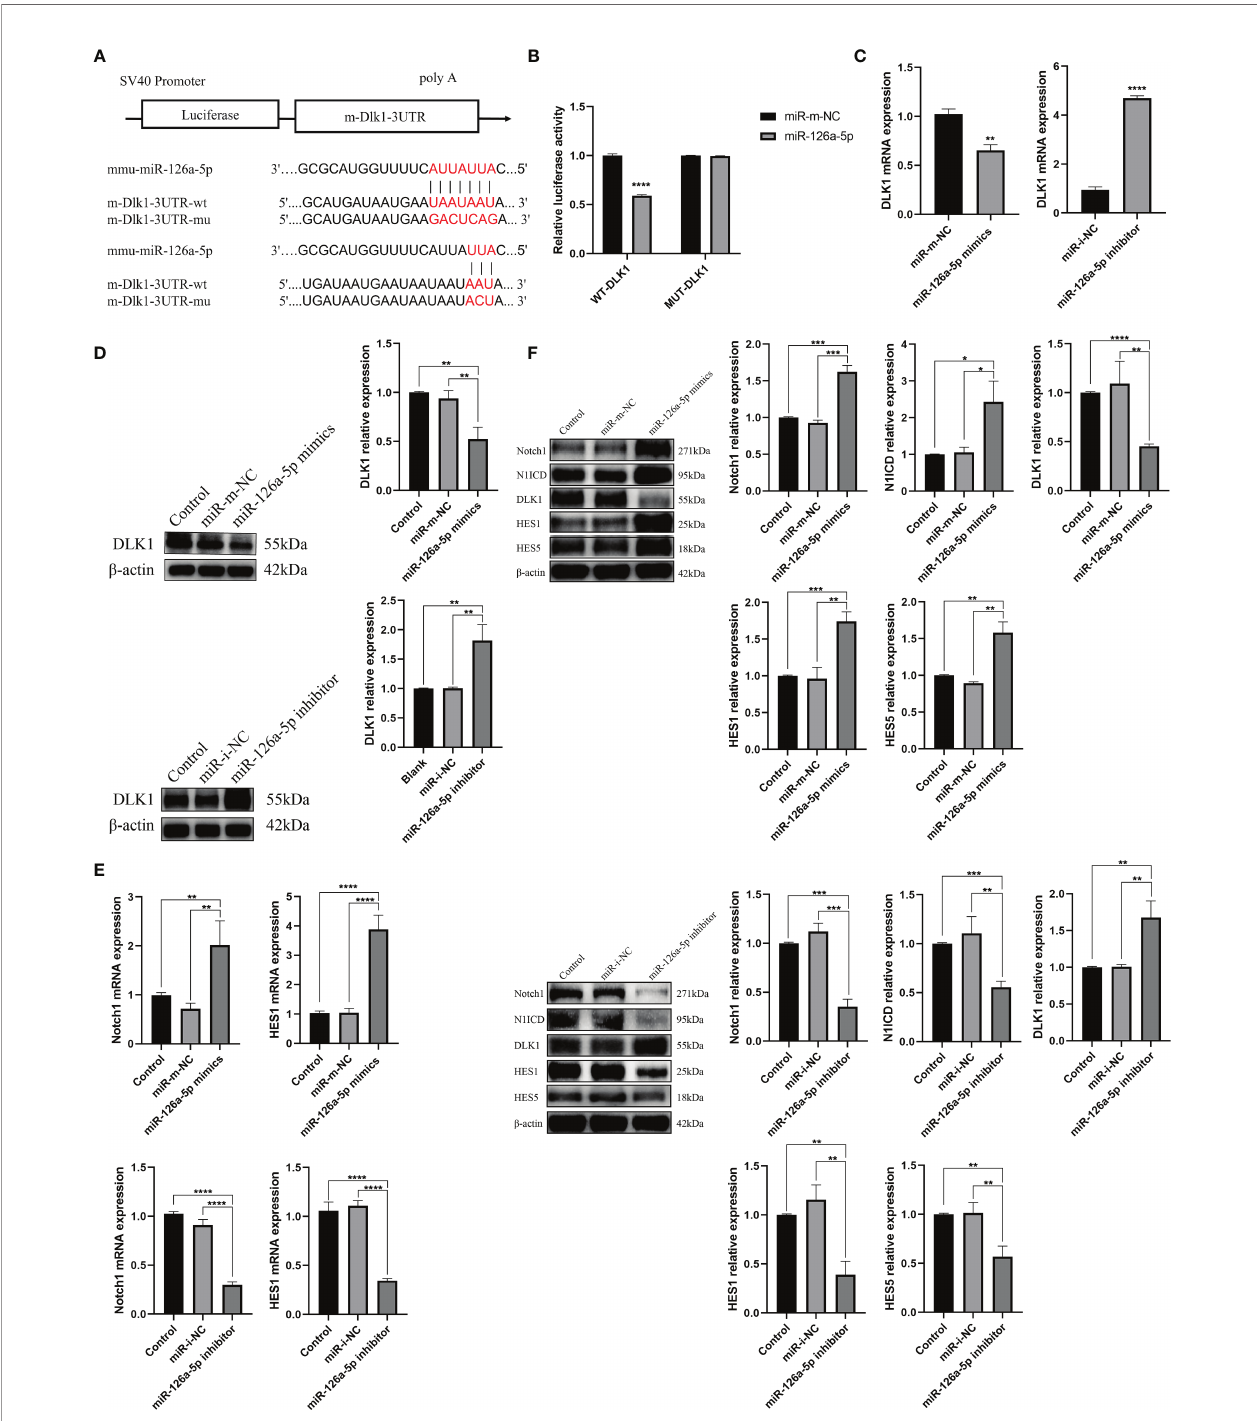
FIGURE 3 | miR-126a-5p regulates the Notch1 signaling pathway by targeting DLK1. (A) Predicted binding site of miR-126a-5p on DLK1. (B) The luciferase activity of mir-126a-5p binding to DLK1 was measured by dual luciferase reporter gene. (C) DLK1 mRNA expression after transfection with miR-126a-5p mimics or miR- 126a-5p inhibitor in naive CD4 + T cells determined by qRT-PCR. (D) DLK1 protein expression after transfection with miR-126a-5p mimics or miR-126a-5p inhibitor in naive CD4 + T cells by Western blot. (E) Notch1 and HES1 mRNA expression after transfection with miR-126a-5p mimics or miR-126a-5p inhibitor in naive CD4 + T cells determined by qRT-PCR. (F) The protein expression of Notch1, N1ICD, DLK1, HES1, and HES5 after transfection with miR-126a-5p mimics or miR-126a-5p inhibitor in naive CD4 + T cells by Western blot. * P < 0.05, ** P < 0.01, *** P < 0.001, **** P <